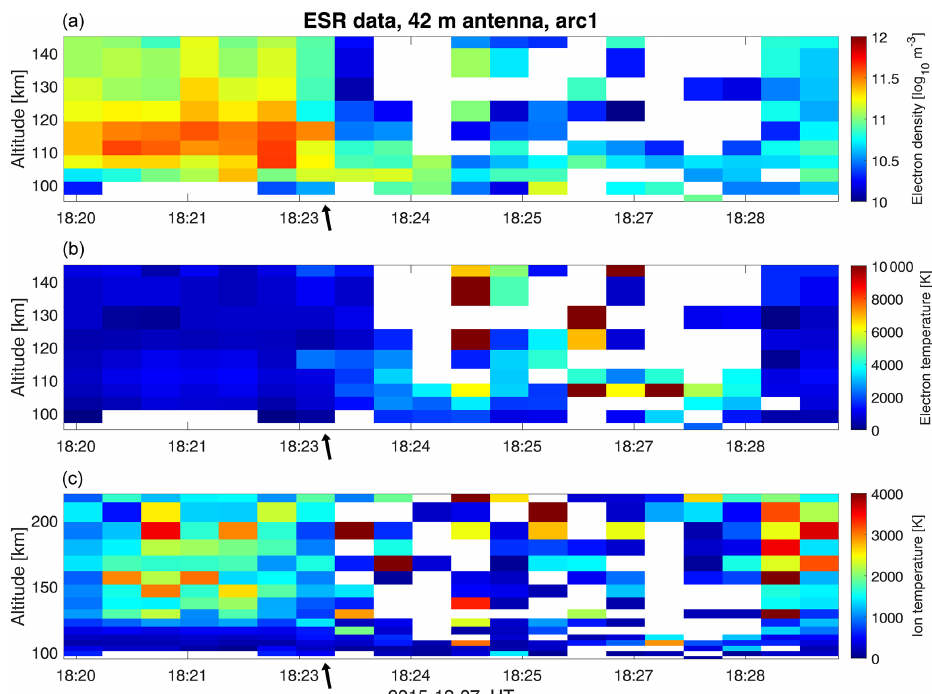
Figure 6. Incoherent scatter data from the ESR (analysed with GUISDAP (Grand Unified Incoherent Scatter Design and Analysis Package) software) for 18:20–18:30UTC on 7 December 2015, with electron densities in (a) , electron temperatures in (b) , and ion temperatures in (c) . Data points with errors > 50% of the values were removed. Further limiting to > 30% would only remove a few extra data points. Errors for the relevant time periods up to the FAE passing are < 20% of the values. The arrows mark the time of the FAE